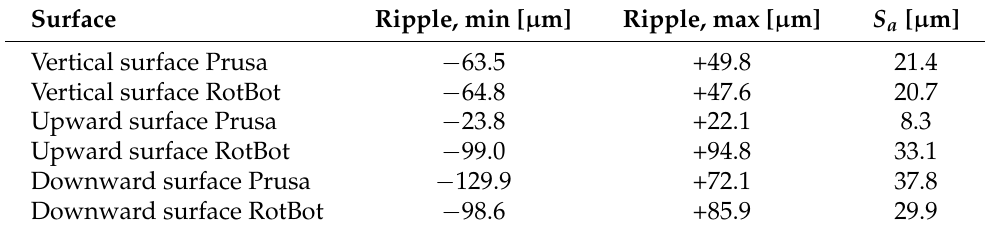
Figure 22. Roughness scans of the horizontal, upward surface. Prusa ( left ) and RotBot ( right ). Table 2. Values of surface scan.